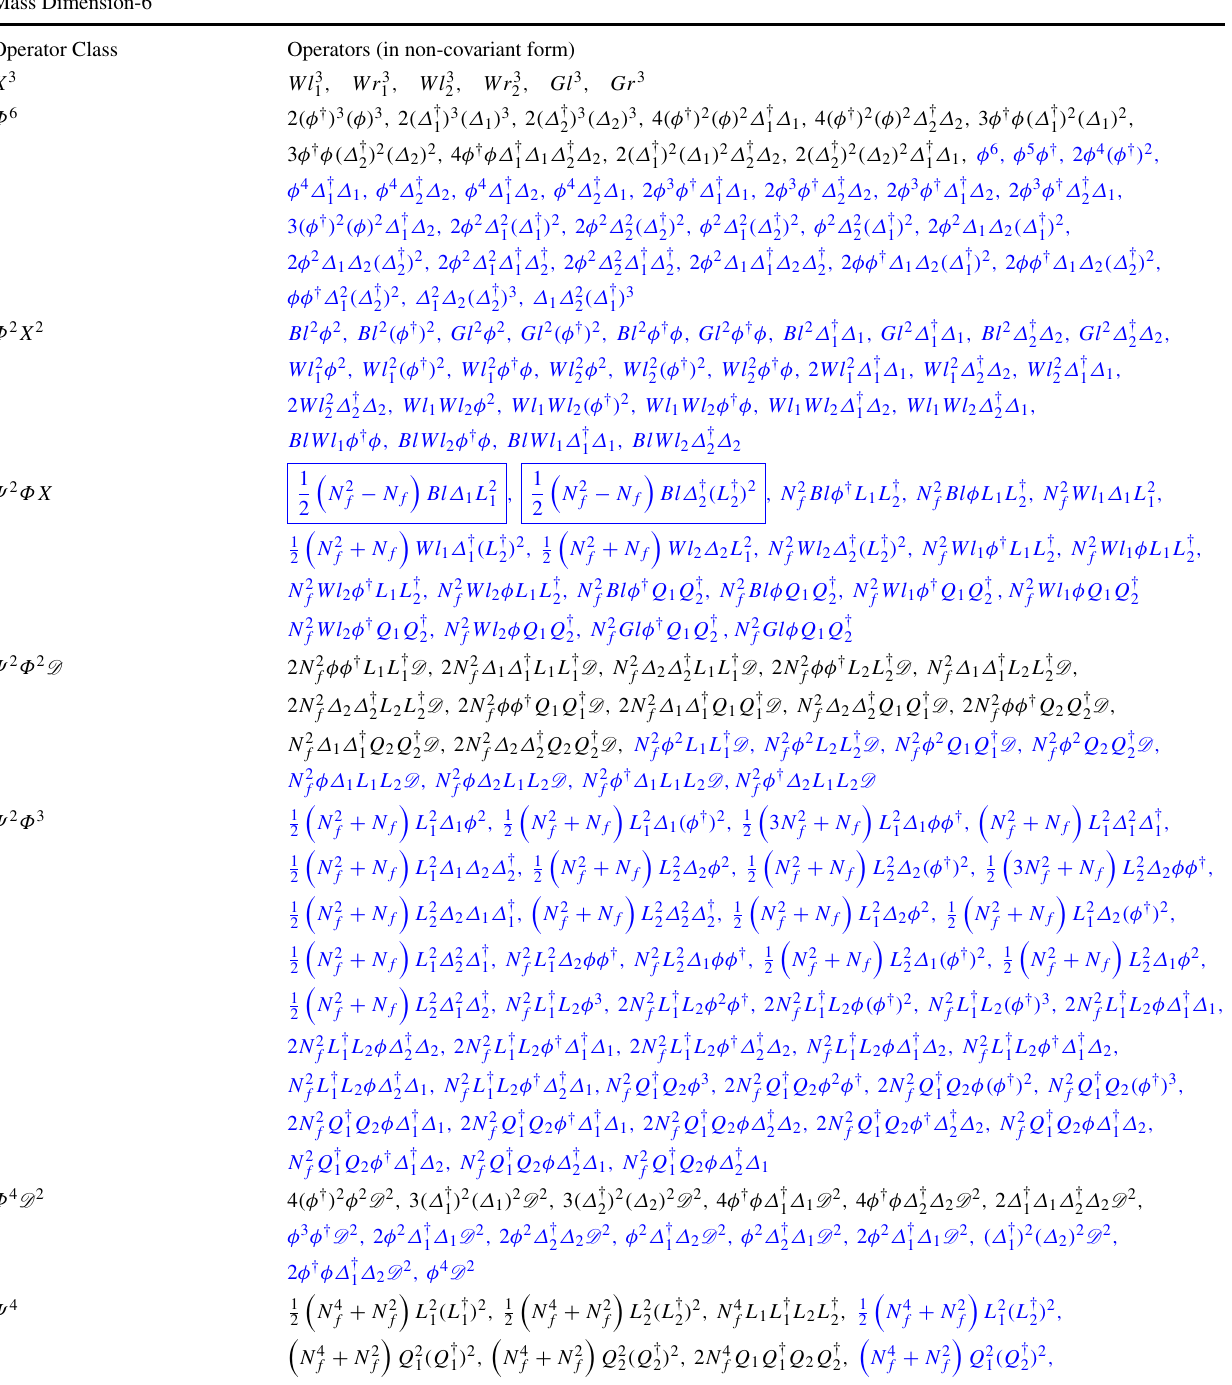
Table 48 MLRSM: Operators of mass dimension-6. Operators in blue have distinct hermitian conjugates and boxed operators vanish for N f = 1. There are no operators of mass dimension-5 in this case Mass Dimension-6 Operator